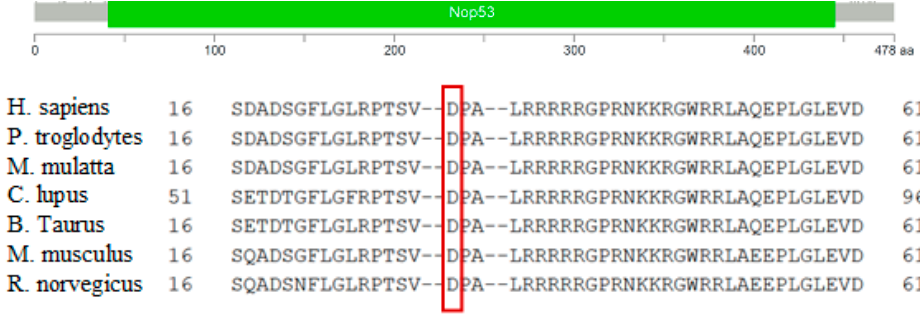
Figure 3. Protein domain architecture of NOP53 (GLTSCR2) and conservation of the p.Asp31 position across species. The red frame highlits the amino acid aspartic acid (D) at position 31.